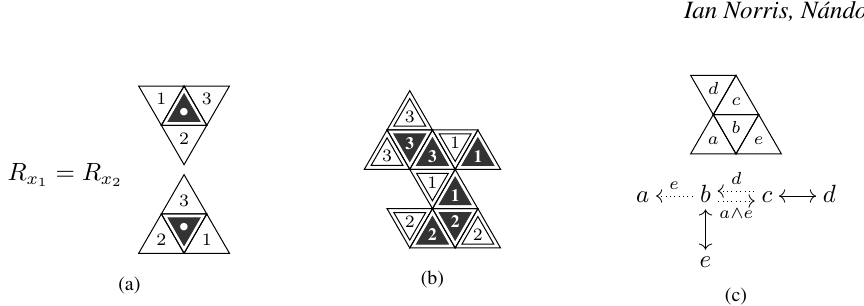
Figure 4: (a) A (2 , 2) priority strategy. The bullets indicate the marks of the maker in the current turn. (b) A possible game play where the breaker follows the priority strategy. The marks of the maker are black while the marks of the breaker are white. (c) A dependency digraph of a placement of a goal